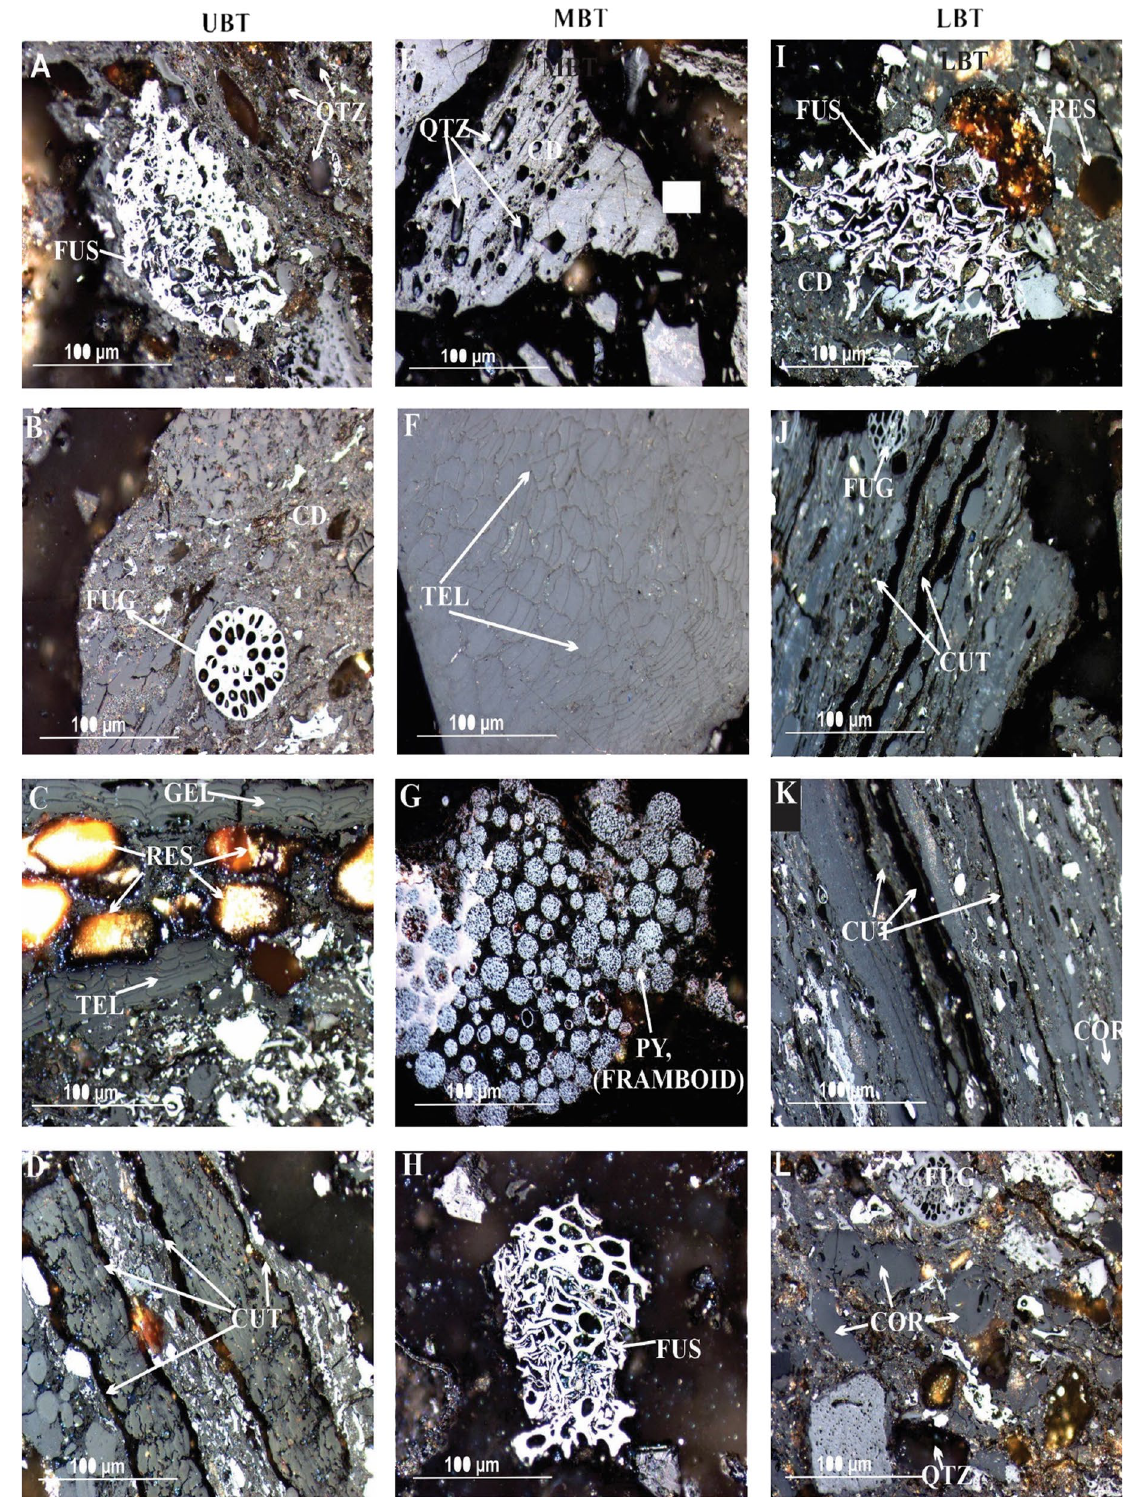
Fig. 4 Selection of macerals observed (× 500, scale-bar is 100 µm; oil immersion, reflected light) (UBT: A–D ; MBT: E – H and LBT: I – L ). Note : (QTZ: Quartz; FUS: Fusinite; TEL:Telinite; GEL: Gelinite;